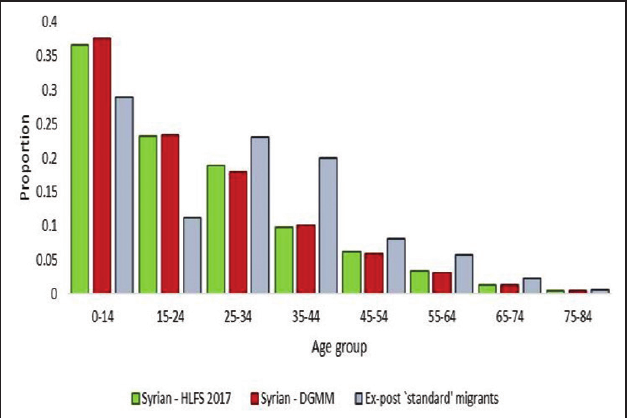
Syrian refugees’ population pyramid, HLFS vs.